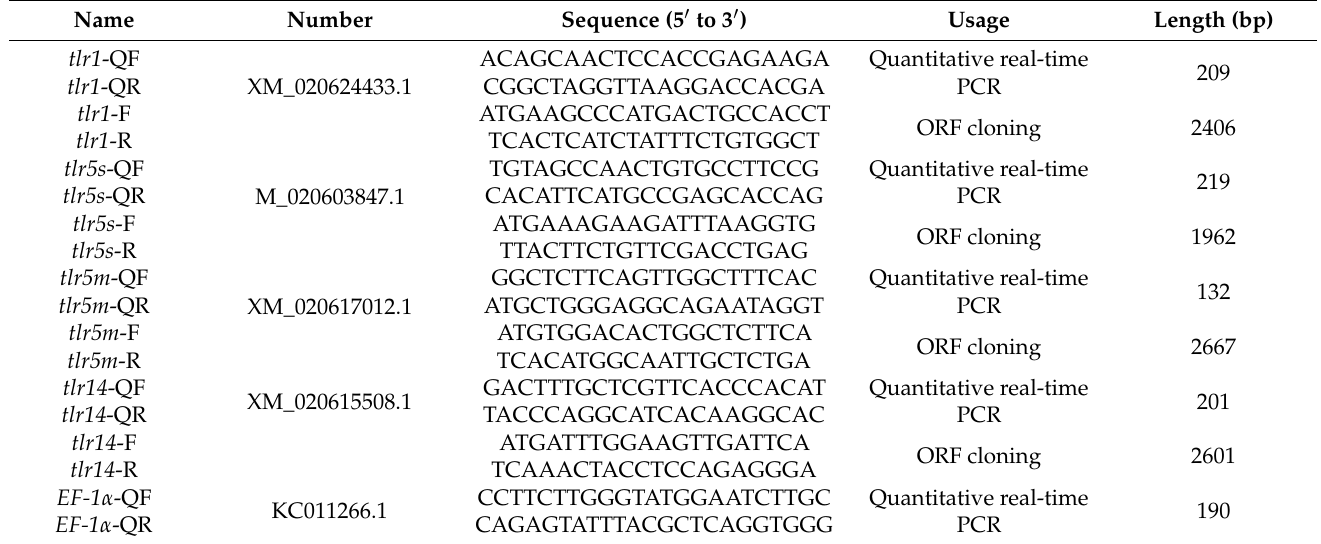
Table 1. The primers used in this